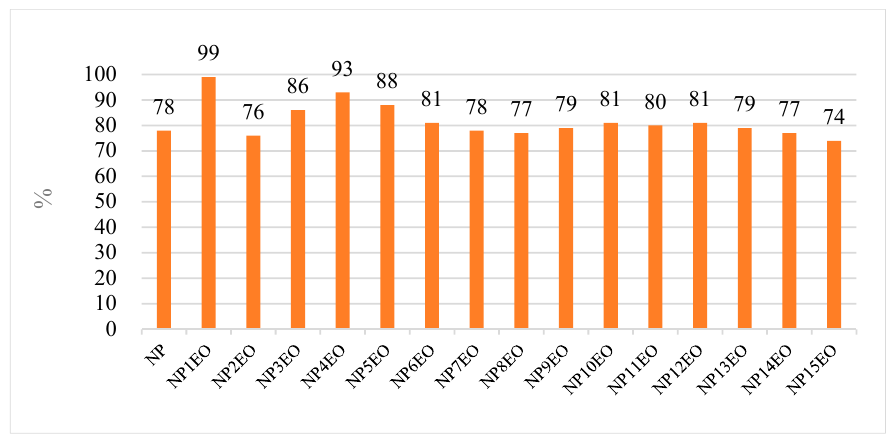
Figure 2. Recovery rate for nonylphenol and individual nonylphenol ethoxylate(s).